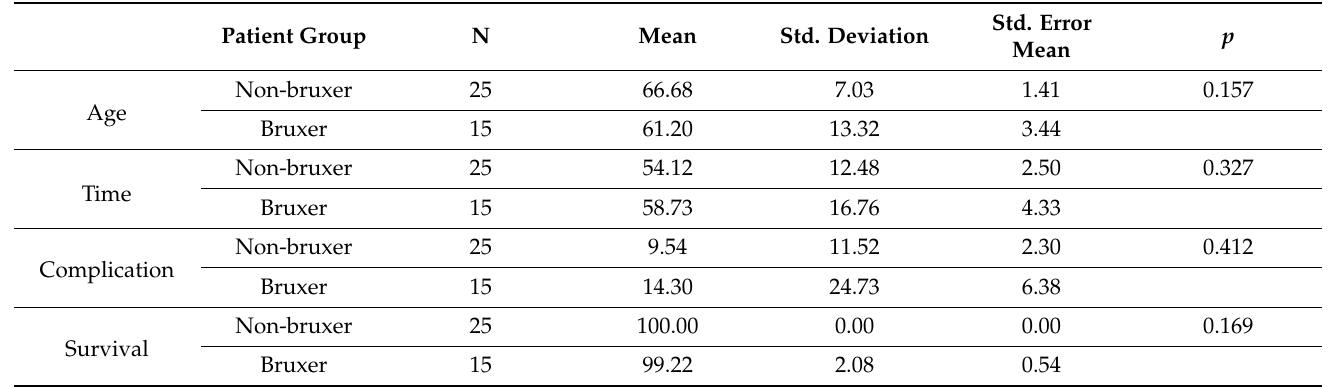
Table 2. Student’s t -test for mean age, follow-up time, complication, and survival rate.